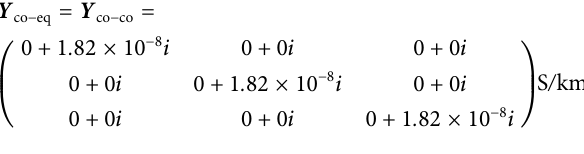
deviation ratio